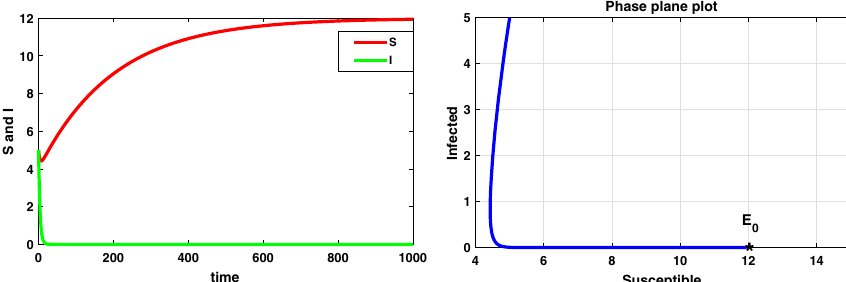
Fig. 1 A dynamical behaviour of the integer-order model with r < µ and the corresponding two-dimensional phase plane portrait of S,I